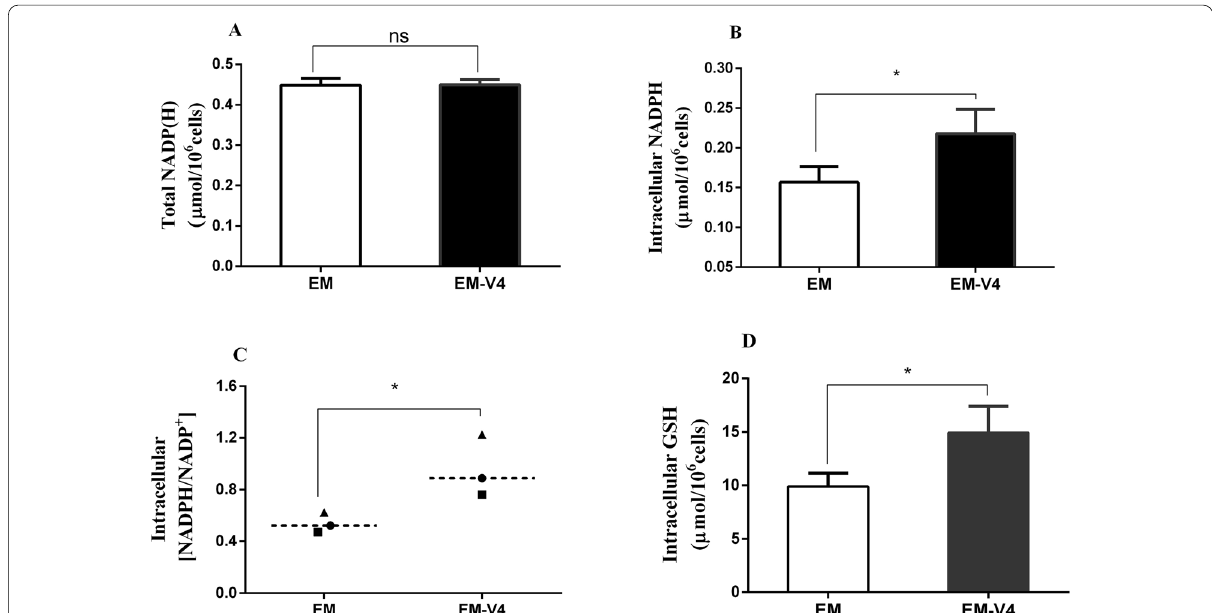
Fig. 5 Content of intracellular metabolites is related to the physiological state of NK‑92 cells. A Total NADP(H). B NADPH. C NADPH/NADP. + ratio. D Intracellular GSH level. (* P < 0.05, n =